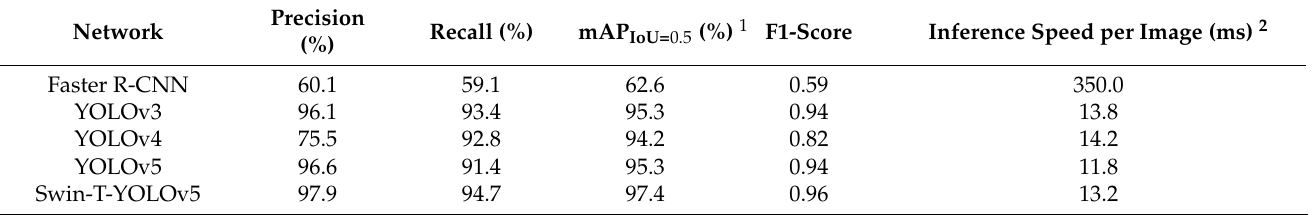
Table 4. Comparison of training and validation results for Faster R-CNN, YOLOv3, YOLOv4,